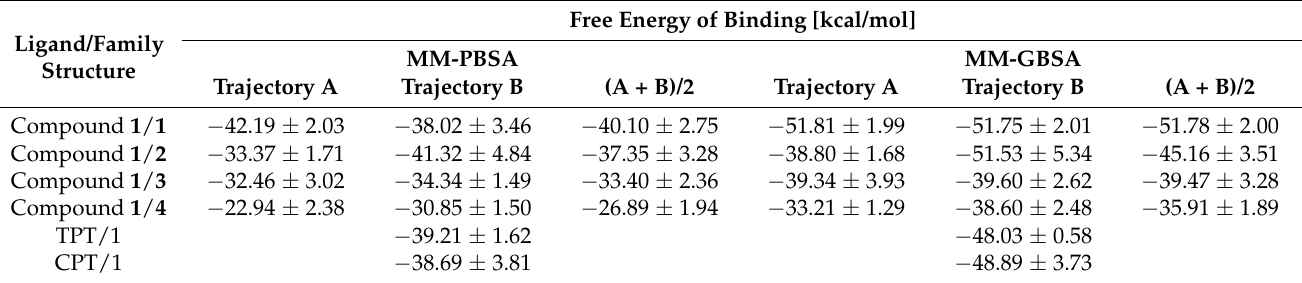
Table 3. MM-PBSA and MM-GBSA results of calculations for ligand/DNA/Topo I ternary